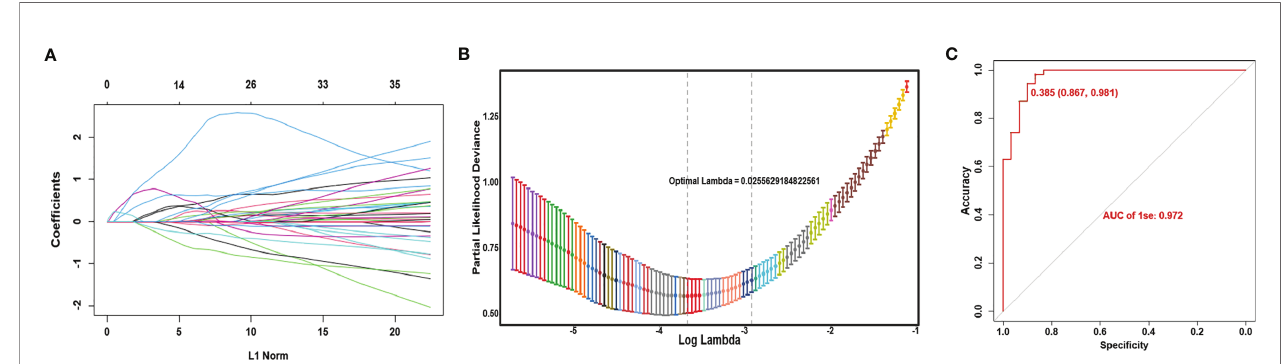
FIGURE 6 | Construction of gene expression model to predict the immune in fi ltration phenotypes. (A) Coef fi cient pro fi les of variables in the LASSO regression model. (B) Tenfold cross-validation for turning parameter ( l ) selection in the LASSO Cox regression model. (C) ROC curve of the model in the TCGA